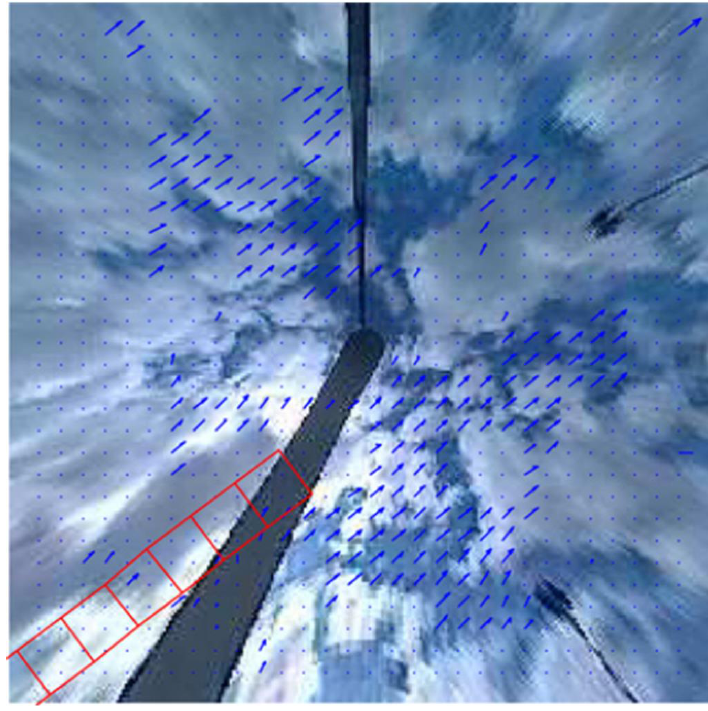
Figure 4. Cloud motion vector prediction in